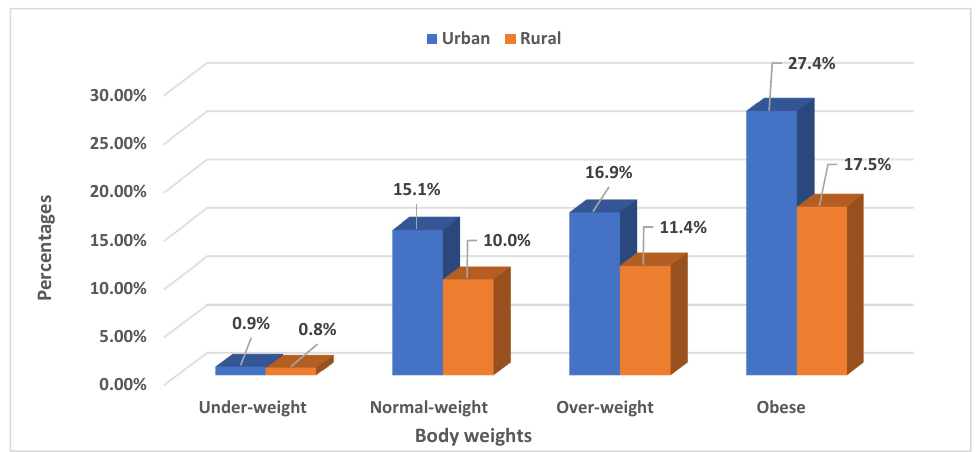
Figure 3. Body weight among women of childbearing age (15–49 years) by urban–rural variations in South Africa. Source: SADHS, 2016.